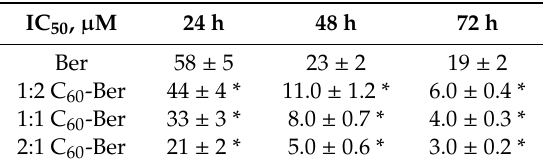
Table 5. Half-maximal inhibitory concentration (IC 50 ) of the free Ber and C 60 -Ber nanocomplexes towards CCRF-CEM